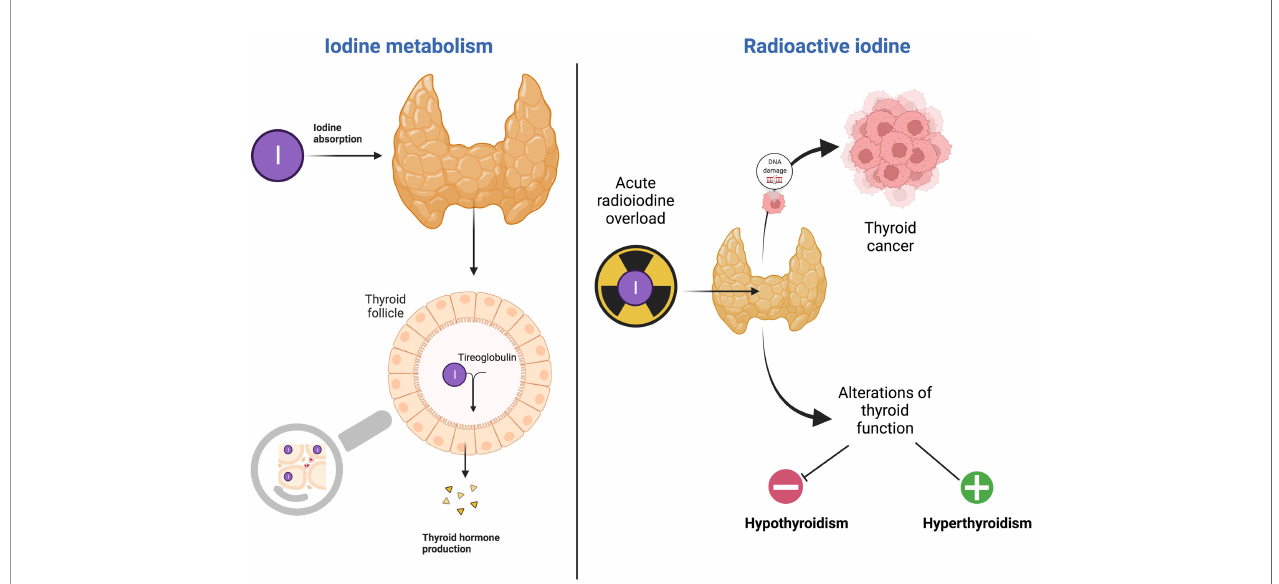
FIGURE 1 | Radioiodine impact on the thyroid disorders (created by using